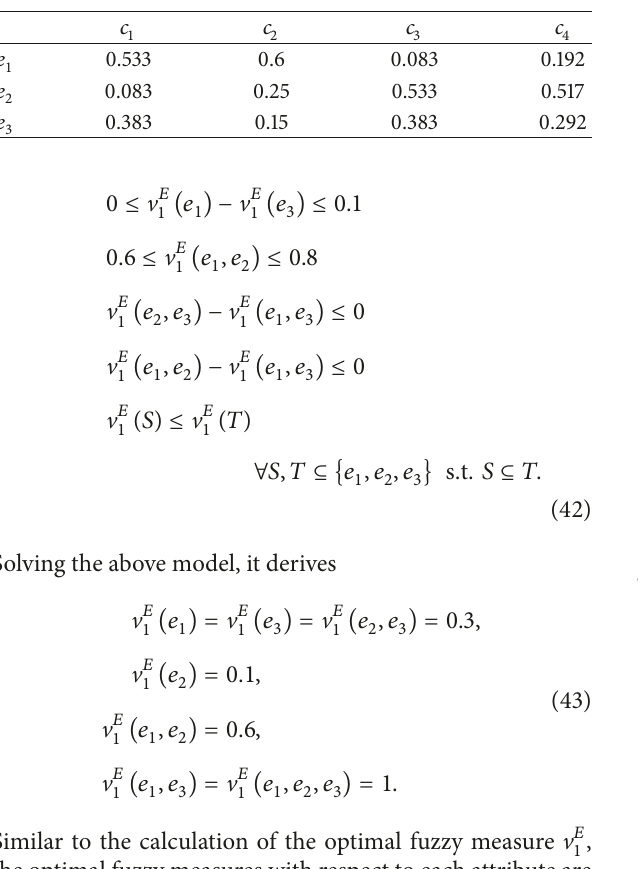
Table 6: The experts’ Shapley